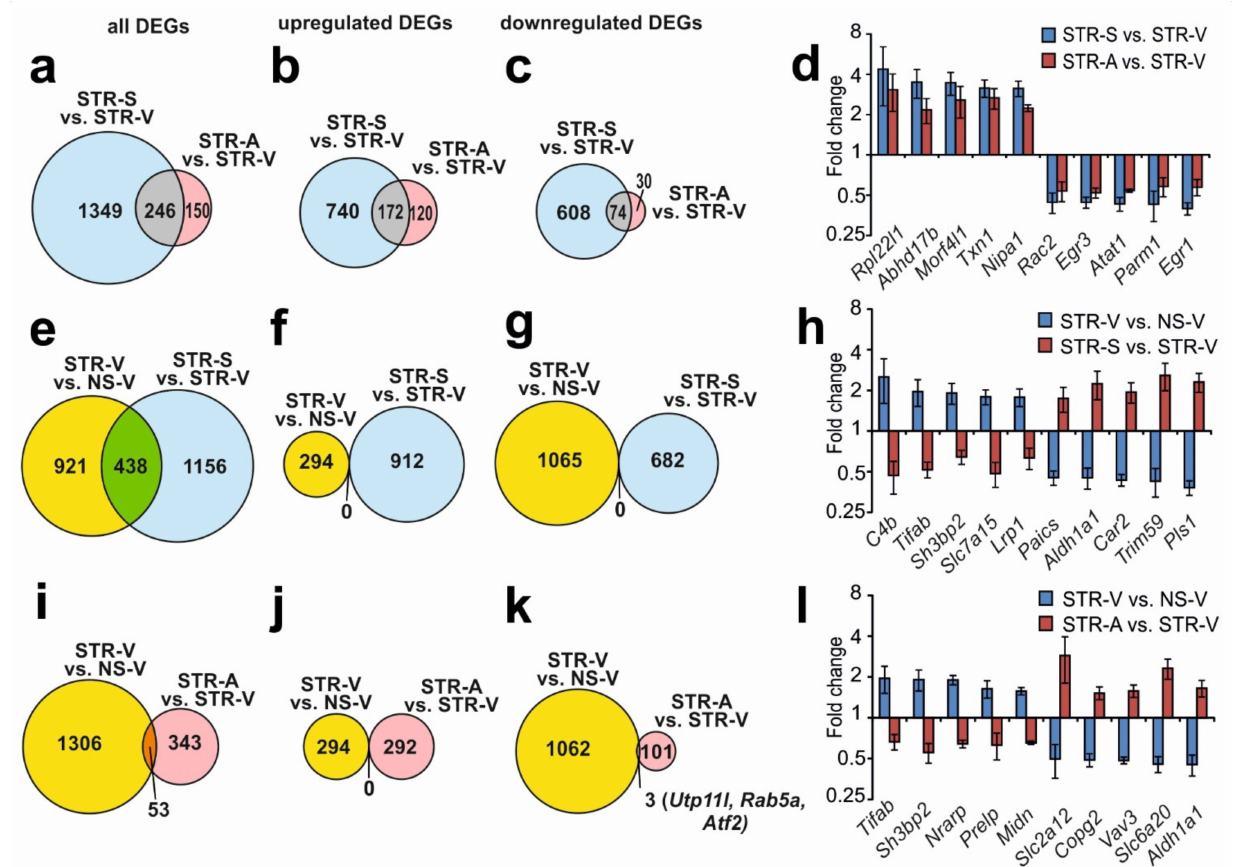
Figure 3. Analysis of RNA-Seq results in different comparison groups. ( a , c , e ) Schematic comparisons of the results obtained in pairwise comparisons of STR-S vs. STR-V, and STR-A vs. STR-V ( a – c ); STR-V vs. NS-V and STR-S vs. STR-V ( e – g ); and STR-V vs. NS-V and STR-A vs. STR-V ( i – k ) are represented by Venn diagrams. Comparison for all ( a , e , i ), or upregulated ( b , f , j ) or downregulated ( c , g , k ) DEGs. ( d , h , l ) The top 10 genes that exhibited the greatest fold change in expression in STR-S vs. STR-V ( d ) or STR-V vs. NS-V ( h , l ), and lie within the intersection of the gene sets on the Venn diagram ( a , f , i ), respectively. The data are presented as the mean ± standard error of the mean. The cutoff of gene expression changes was 1.50-fold. Only those genes with Padj < 0.05 were selected for